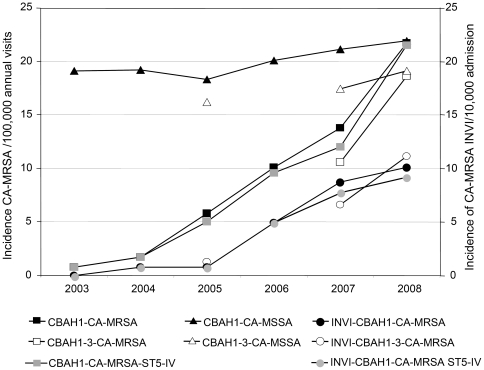
Evolution of community-associated Staphylococcus aureus infections from children in Cordoba-Argentina, 2003–2008.Evolution of the rates of all community-associated Staphylococcus aureus infections: i) methicillin-resistant S. aureus (CA-MRSA) infections [total (squares) and invasive-INVI (circles)], and ii) total methicillin-susceptible S. aureus (CA-MSSA) infections (triangles) in Córdoba children's hospitals, [H1 (CBAH1): 2003–2008: filled figures, and in H1, H2 and H3 (CBAH1-3): 2005 vs 2007–2008: empty figures] iii) methicillin-resistant community-associated Staphylococcus aureus infections caused by the ST5-IV-PVL+clone [total (gray squares) and invasive (INVI) (gray circles)] in H1 (CBAH1): 2003–2008.